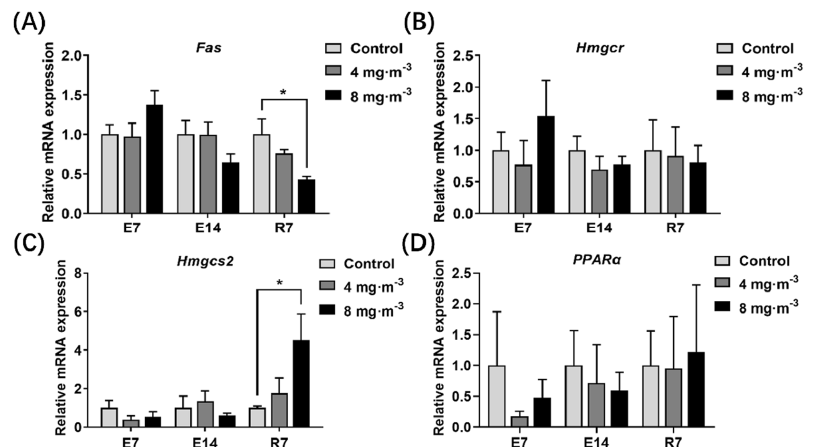
Figure 8. Effects of particulate matter exposure on relative mRNA expression levels of genes related to lipid metabolism in the liver of broilers. ( A – E ) represent the Fas , Hmgcr , Hmgcs2 , and PPARα levels in serum of broilers after E7, E14, and R7, respectively. Data are presented as mean ± SEM of groups (n = 8). * p < 0.05. E7, exposure for 7 days; E14, exposure for 14 days; R7, recovery for 7